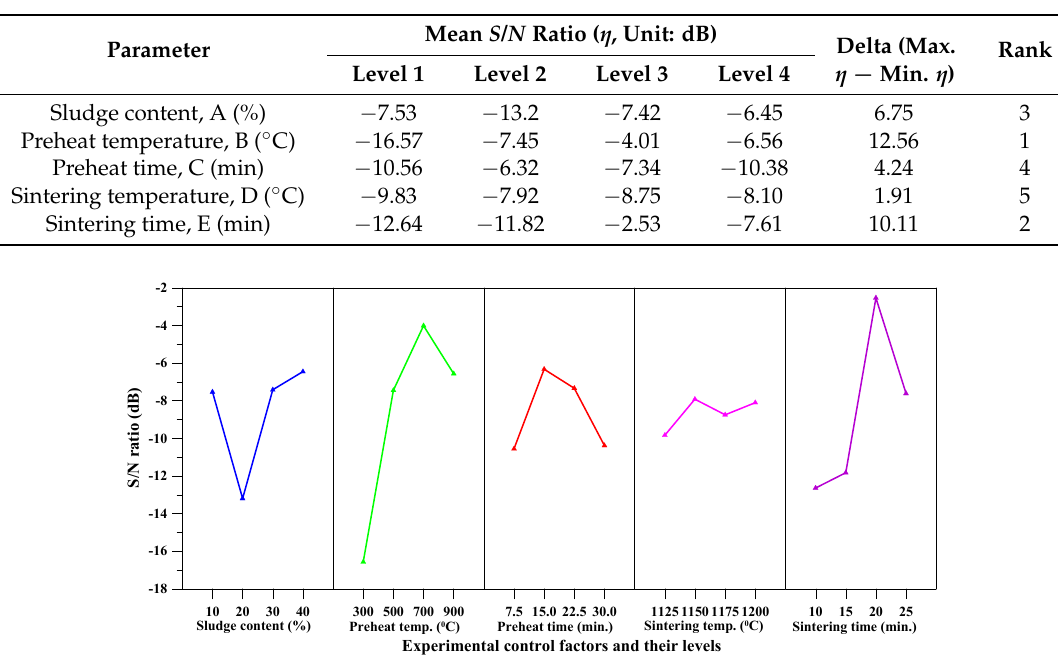
Table 9. Analysis of variance and F test for water